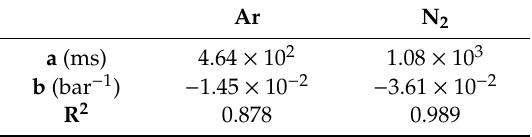
Table 2. Coe ffi cient values for the exponential regression t i = a × exp(b × P 0 ) for the 90-10 propellant.